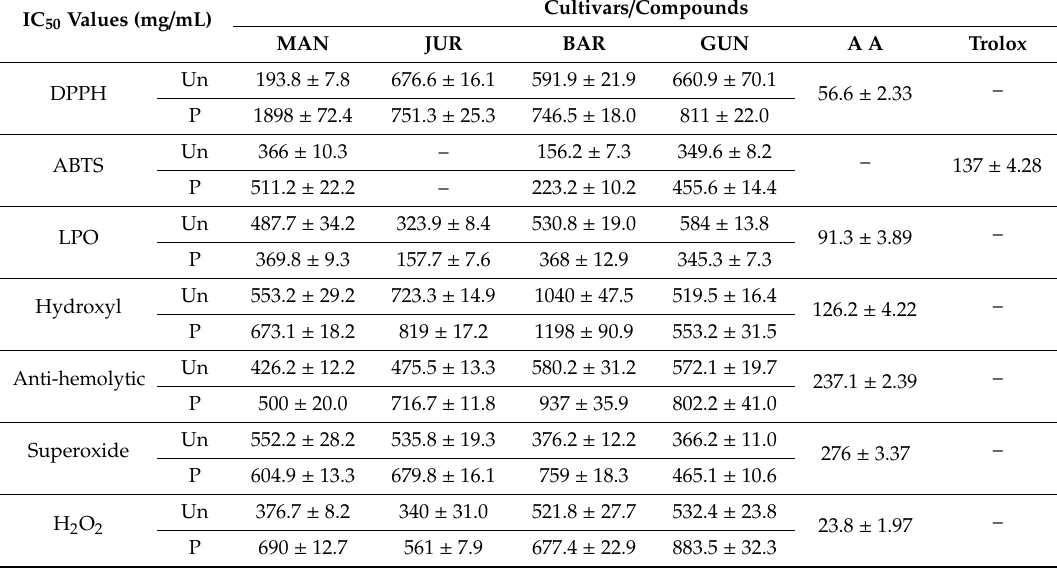
Table 3. IC 50 values of highly active cultivars in di ff erent types of in-vitro antioxidant test.